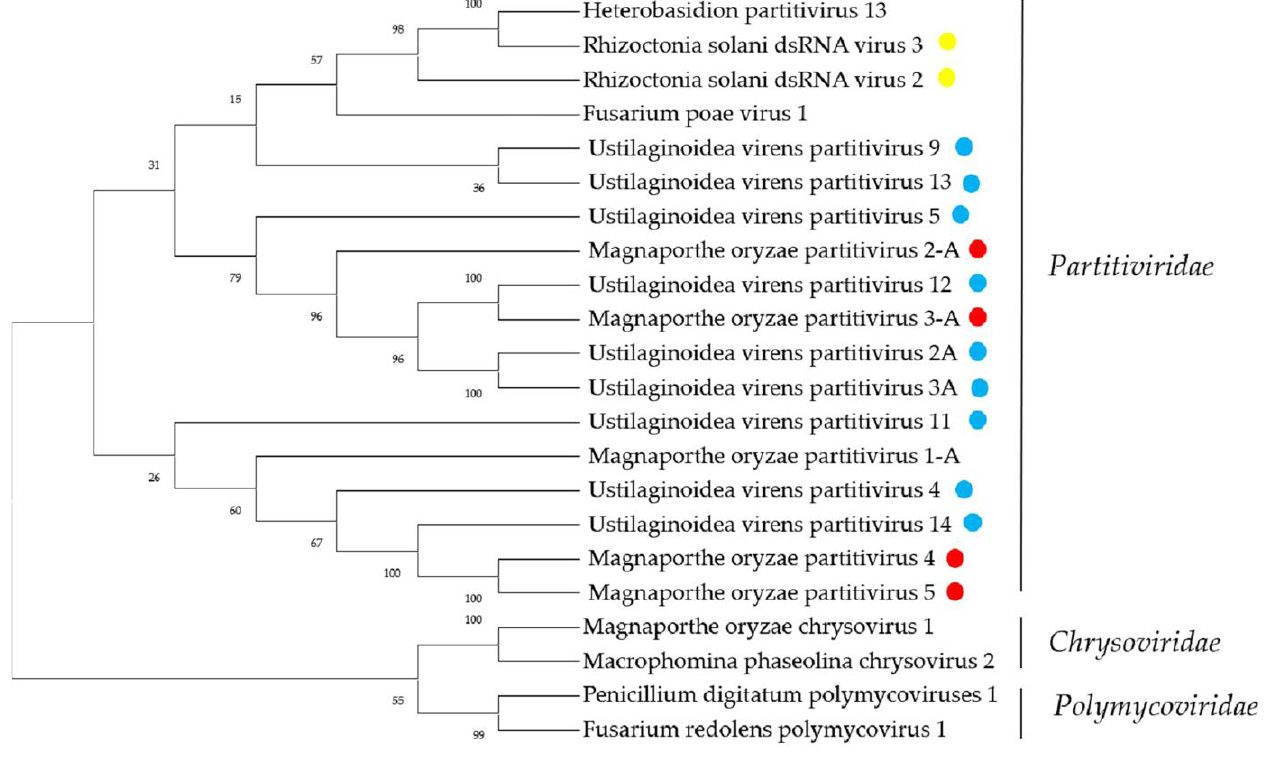
Figure 5. Phylogenetic analysis of viruses in the family Partitiviridae . Neighbor-joining-method phylogenetic tree based on the core RdRP motifs of putative viruses in the family Partitiviridae , other related viruses, and representatives of the family. Viruses marked with red color are found in P. oryzae , blue color in U. virens , and yellow color in R. solani . The viruses without a color annotation are the representatives of the known species of each viral